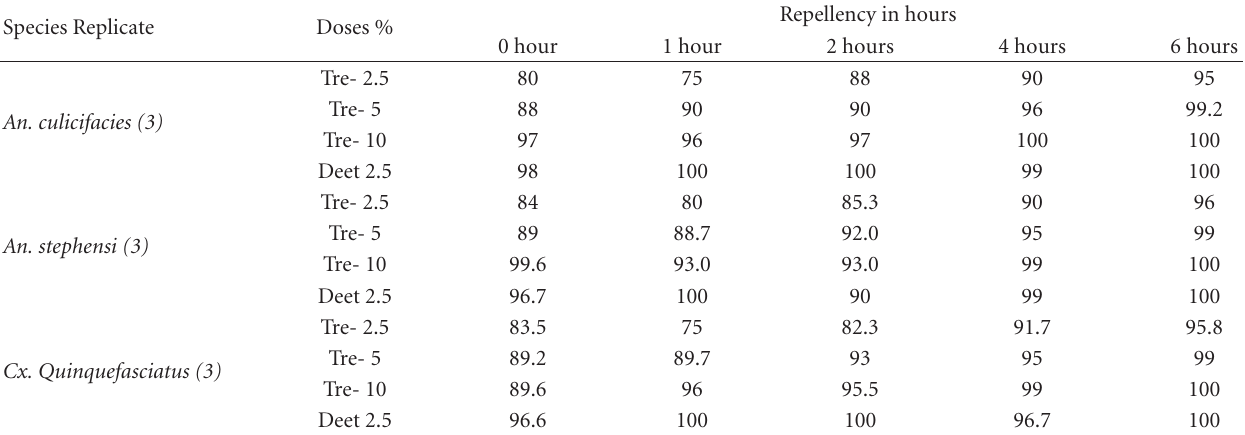
Table 1: Percent repellency of hexane extract of tuber of root of Cyperus rotundus Linn against three important mosquito vectors. Species